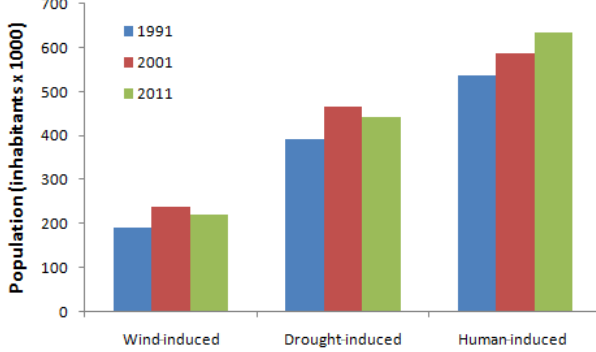
Figure 8. Population trend of three zones of desertification from 1991 to 2011. The population trend has been significantly increased (8%) from 2001 to 2011 in the human-induced desertified zone, where as in the temperature/drought, wind and rainfall-affected zone, it follows a decreasing trend. This is because of the migra- tion of the inhabitants towards urbanized area in order to stabilize their economical needs during drought